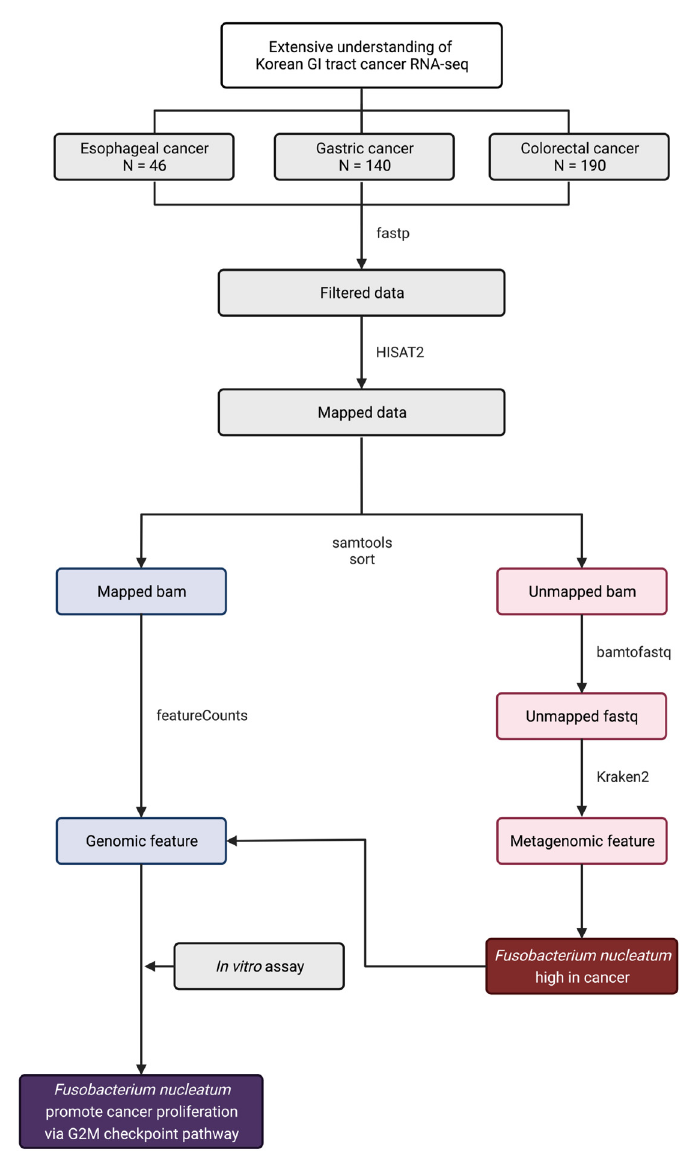
Figure 1. Flow of WTS data processing. Overall flow of WTS data processing for genomic feature and metagenomic feature analysis.